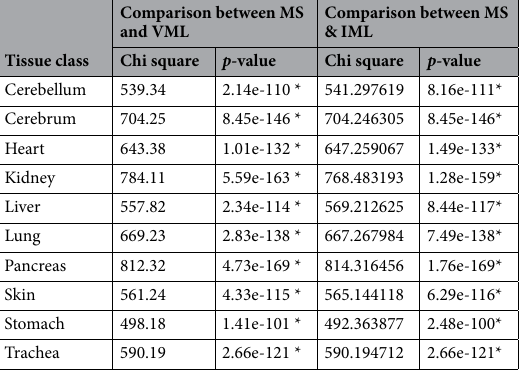
Table 9. Tissue wise agreement (Chi squared Goodness of Fit) between MS, VML & IML in the quiz questionnaire ( n = 100). Significance of *: indicates statistically significant